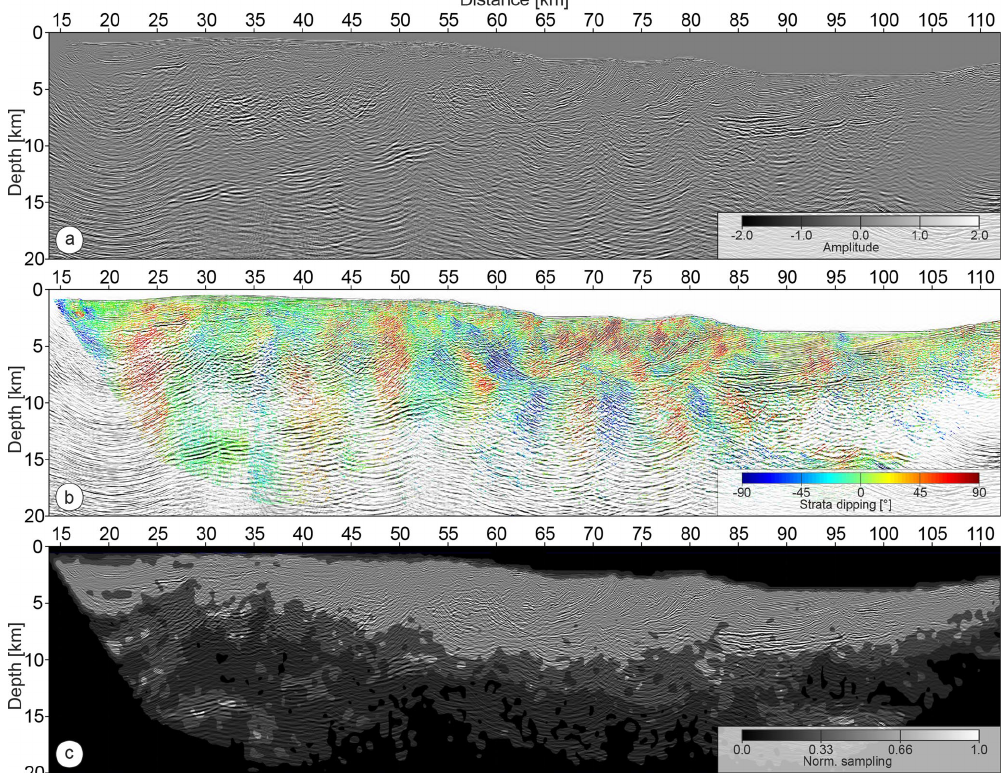
Figure 7. (a) PSDM section inferred from the FWI velocity model. (b) Cloud of the scattering points corresponding to picked slopes. Colors represent estimated dipping of the interfaces. (c) Normalized average sampling of the model space by the scattering points superimposed over the PSDM section from (a)